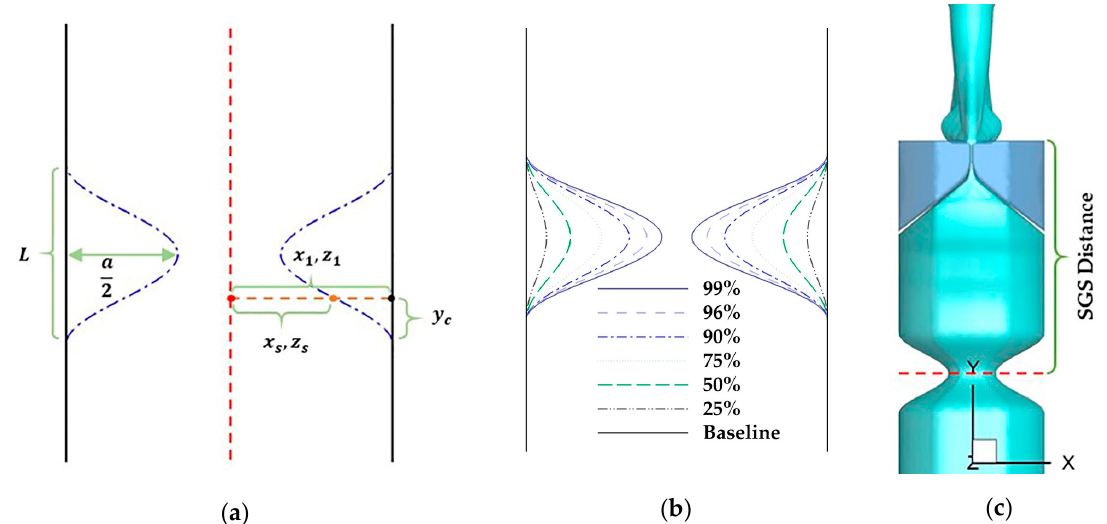
Figure 2. ( a ) Schematics of the cross-section of an idealized subglottic stenosis (SGS) geometry and the parameters used in Equation (5), to create the SGS. ( b ) The different values of SGS severity, which is defined as the percentage of area reduction due to SGS. ( c ) The SGS location, defined as the distance between the narrowest section of the SGS and superior surface of the vocal folds.